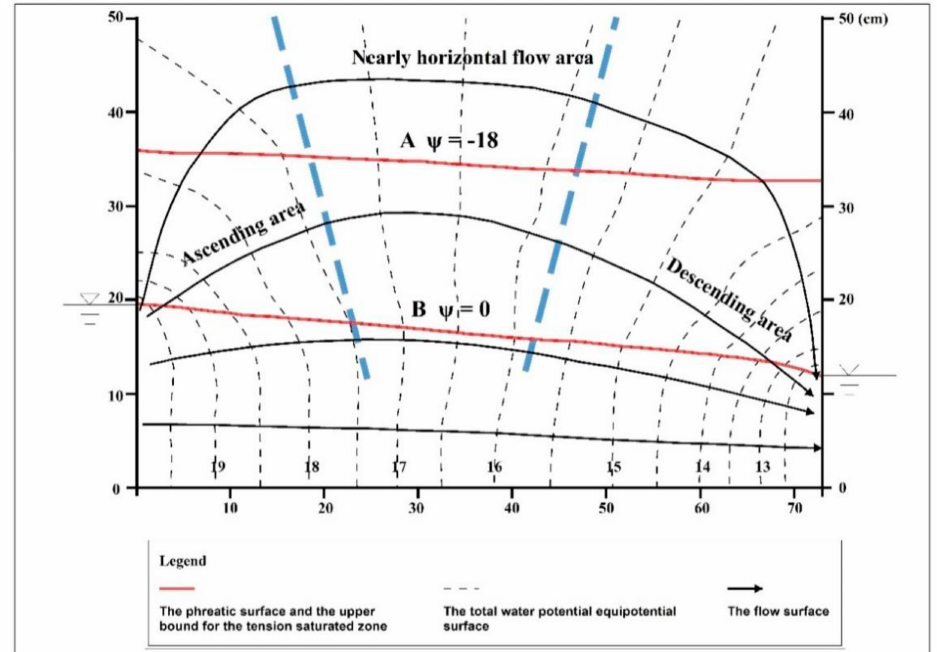
Figure 4. Flow net of the seepage zone as measured in the physical